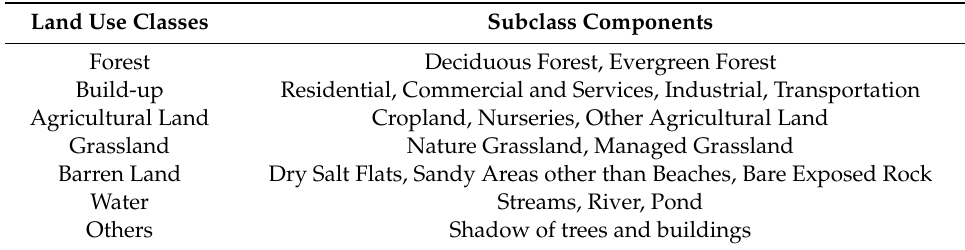
Table 1. The urban land use classes and the corresponding subclass components.